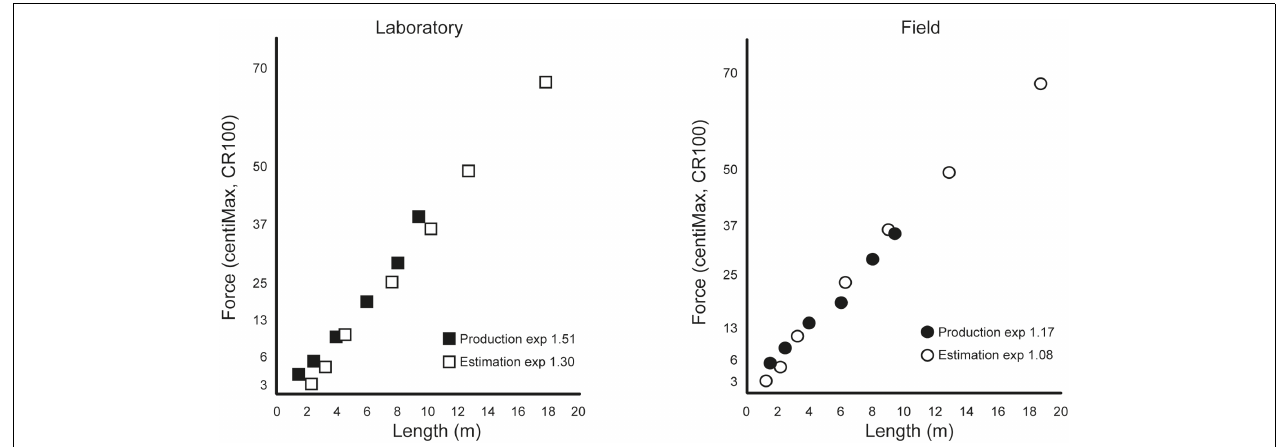
FIGURE 3 | Psychophysical relationships between CR100 intensity and putting length (m) obtained in the laboratory and field part of the preliminary study.